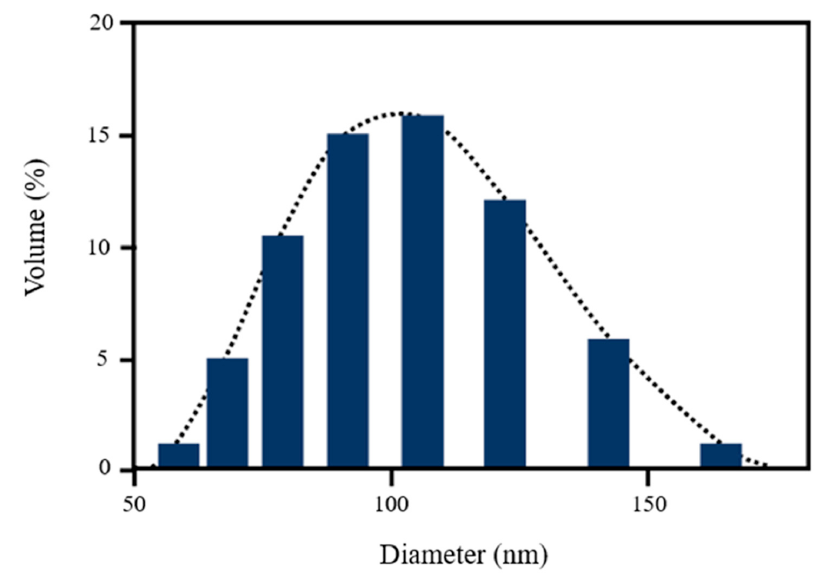
Figure 4. Dynamic light scattering analysis of [ 223 Ra]RaCl 2 nanomicelles, showing a mean size of 149 nm and a PDI of 0.0096 (±0.0002).